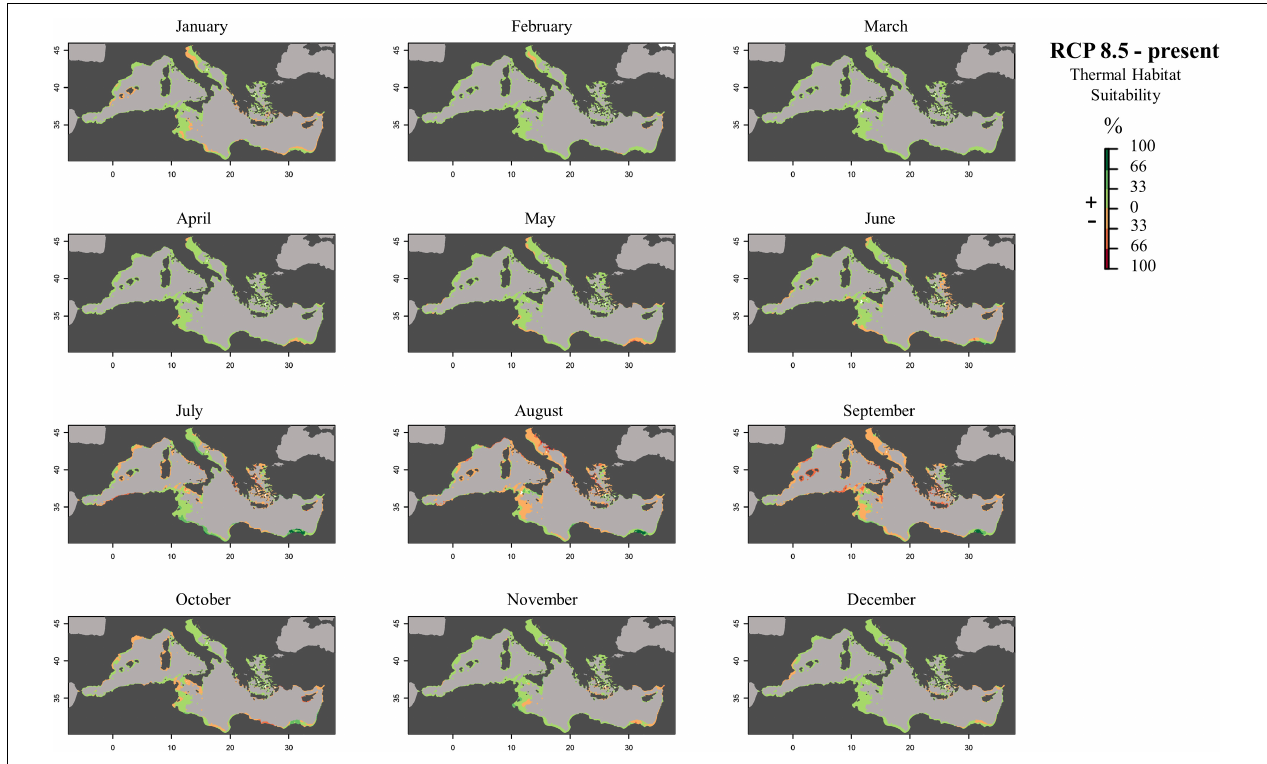
FIGURE 8 | Monthly prediction maps representing the subtraction between future (RCP 8.5) and present raster files: positive percentage values represent an increase in the suitability of the habitat in the future scenario, while negative percentage values represent a decrease in the occurrence probability of the species in that